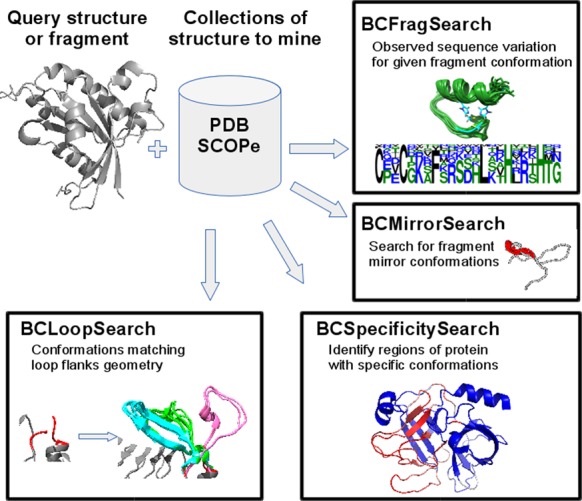
BCSearch services.